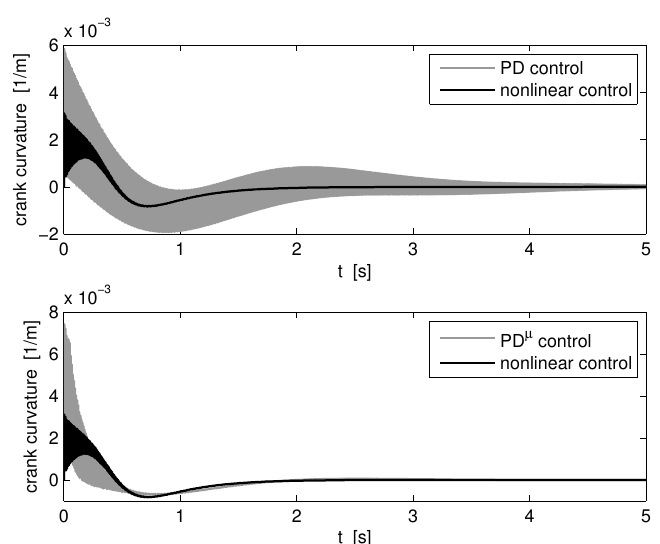
Figure 5. Curvature of the crank, comparison with PD and PD µ controllers.